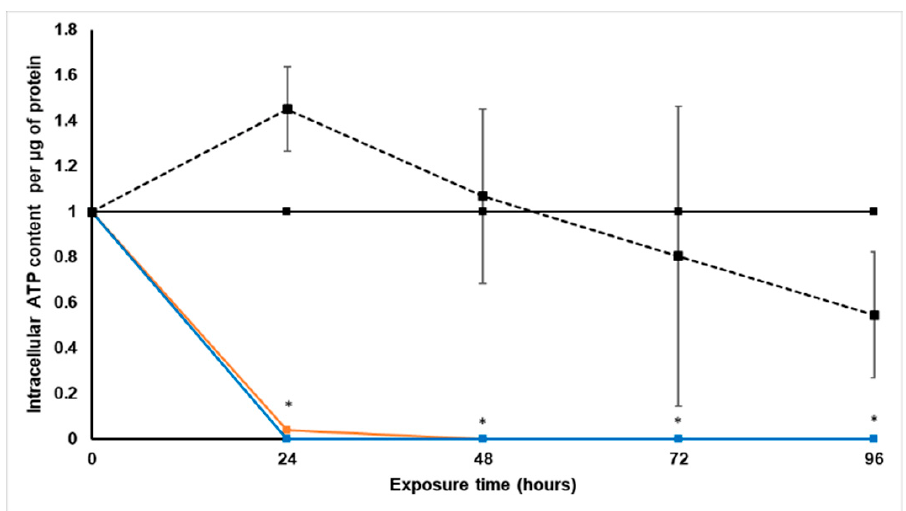
Figure 3. Normalized intracellular adenosine triphosphate content per soluble protein (µM·µg − 1 ) following exposure of the sodium alginate encapsulated LS180 mini-tumor model to Sutherlandia frutescens aqueous extract and paclitaxel. The solid black line represents the untreated control, the black dashed line represents paclitaxel [IC 50 ], the orange line represents S. frutescens [IC 50 ] and the blue line S. frutescens [IC 50 ]/2. All data were normalized to the untreated control group (error bars = standard deviation; n = 3 for S. frutescens [IC 50 ]/2; n = 6 for S. frutescens [IC 50 ] and paclitaxel [IC 50 ];